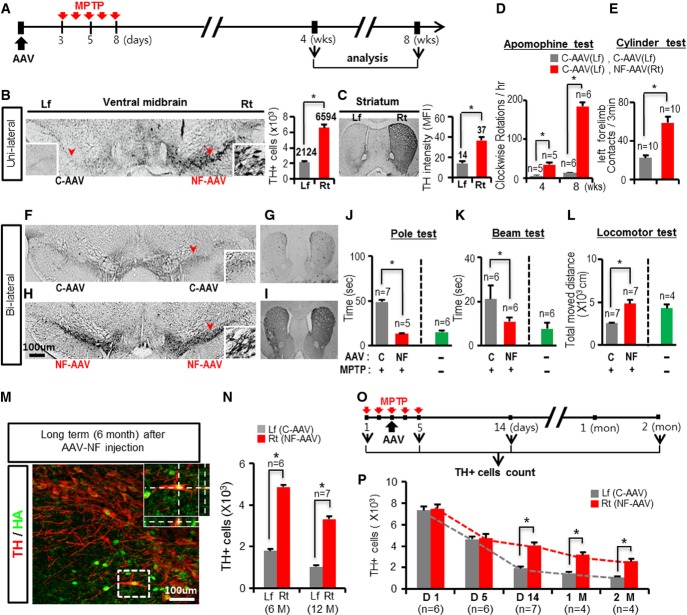
Therapeutic effects of AAV-mediated gene delivery of Nurr1 + Foxa2 in the mouse PD model

A Experimental scheme. As shown, PD model mice were generated by IP injection of MPTP, and AAVs expressing Nurr1 and Foxa2 (NF-AAV) or AAVs expressing empty vector (control, C-AAV) were stereotaxically injected 3 days prior to the initial MPTP treatment.

B–E Cytoprotective and behavioral effects of NF expression were assessed in PD mice unilaterally injected with NF-AAVs on the right side of midbrains. C-AAVs were injected into the left midbrains of the same mice. TH+ mDA neuron numbers in the midbrain (B) and TH+ fiber intensities in the striatum (C) of the NF-AAV-injected right sides were compared with those of the corresponding left sides after 8 weeks. Insets of (B), high-powered images of the areas indicated by red arrowheads in the C-AAV (left) and NF-AAV-injected (right) sides. TH+ cell numbers, *P = 0.000078, n = 7, paired Student's t-test. The sectioned striatal tissues were immunofluorescently stained for TH, and TH+ fiber intensities were estimated from mean fluorescence intensities (MFI). n = 56 microscopic fields at a magnification of 200×  each for the left and right striatum. *P = 0.000003, paired Student's t-test. Behavioral asymmetry in the mice unilaterally injected with NF-AAVs (right side) was assessed using the apomorphine-induced rotation test (D) after 4 and 8 weeks. The cylinder test (E) was carried out after 8 weeks to determine left forelimb movement. As a control, the behaviors were tested in PD mice bilaterally injected with C-AAV. *P = 0.028 (rotation test), 0.043 (cylinder test); one-way ANOVA followed by Bonferroni post hoc test.

F–L Behaviors of the PD mice injected with NF-AAVs bilaterally at both sides of the midbrain were assessed using the pole (J), beam (K), and locomotor (L) tests. *P = 0.004 (pole), 0.044 (beam), and 0.045 (locomotor); one-way ANOVA followed by Bonferroni post hoc test. Shown in (F–I) is a representative TH-stained midbrain (F, H) and striatum (G, I) of mice bilaterally injected with C-AAVs (F, G) and NF-AAVs (H, I).

M, N Sustained mDA neuroprotective effects. Shown in (M) is a confocal image of TH/HA-stained cells 6 months after NF-AAV injection (Foxa2 gene tagged with HA). Inset, z-stacked image of the boxed area along the y-axis (right) and x-axis (lower). TH+ cells in the right (NF-AAV) and left (C-AAV injected) midbrains were counted 6 and 12 months after AAV injection (N). *P = 0.000019 (6M), 0.000066 (12M), n = 6–7, paired Student's t-test.

O, P NF-AAV-mediated mDA neuroprotective effects were further assessed with the experimental schedule (O), in which AAV injections were subjected after three consecutive MPTP injections. Shown in (P) is TH+ cell counts of the left and right sides of the midbrains. *P = 0.000012 (D14), 0.000036 (1M), 0.000027 (2M), n = 6–7, paired Student's t-test.